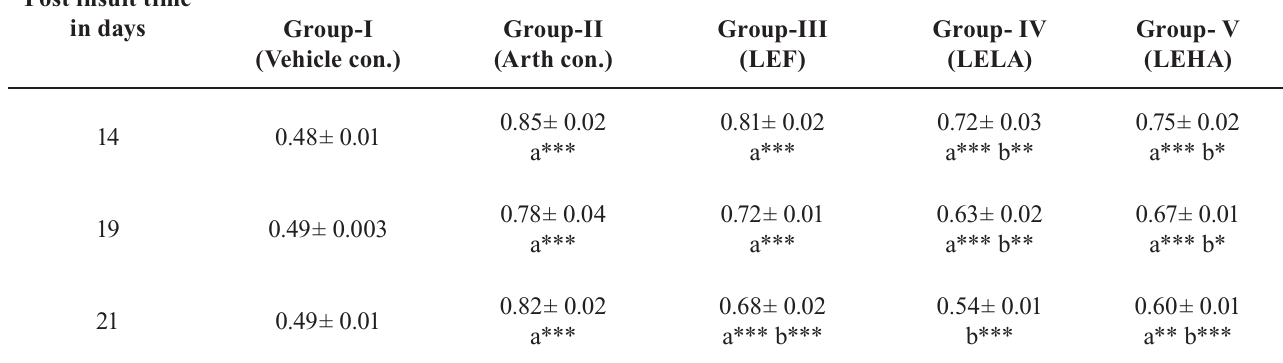
Mean changes in swelling volume (ml) ± SEM on injected paw